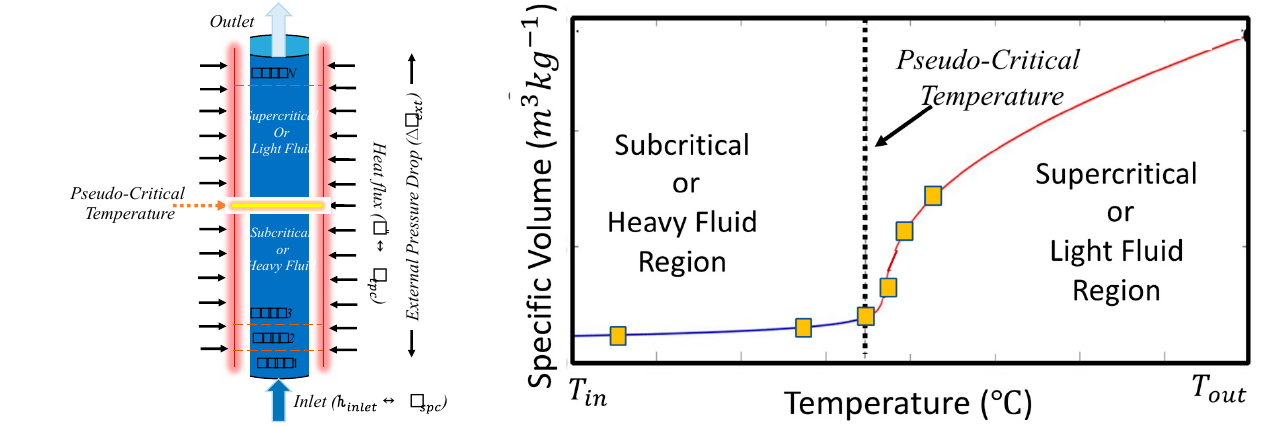
Figure 7. A systematic view of the N-node nodalized heated channel.